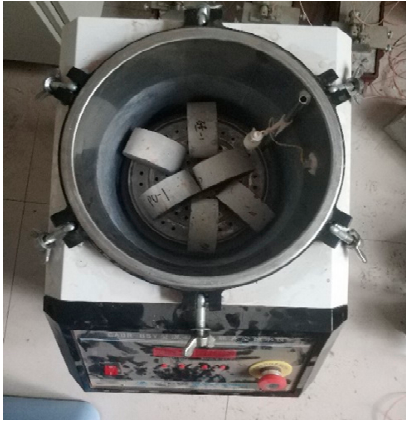
Figure 7. Instrument of vacuum water saturation.